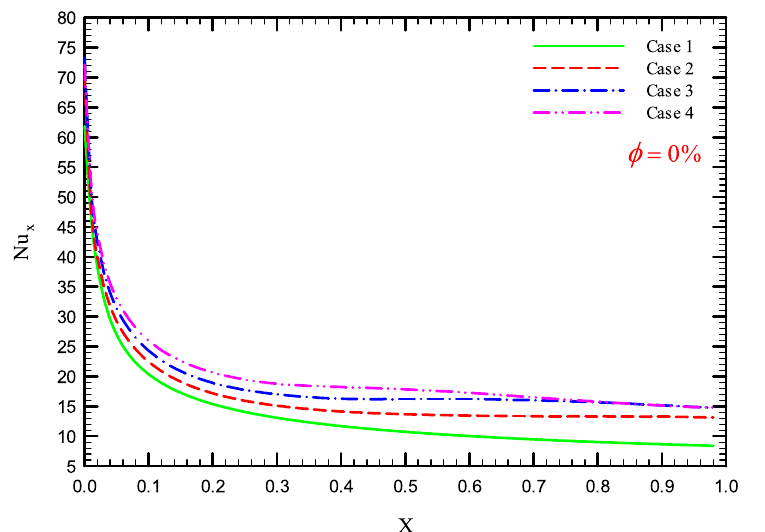
Figure 27. Nu loc versus dimensionless length in φ = 0% in Re = 750.